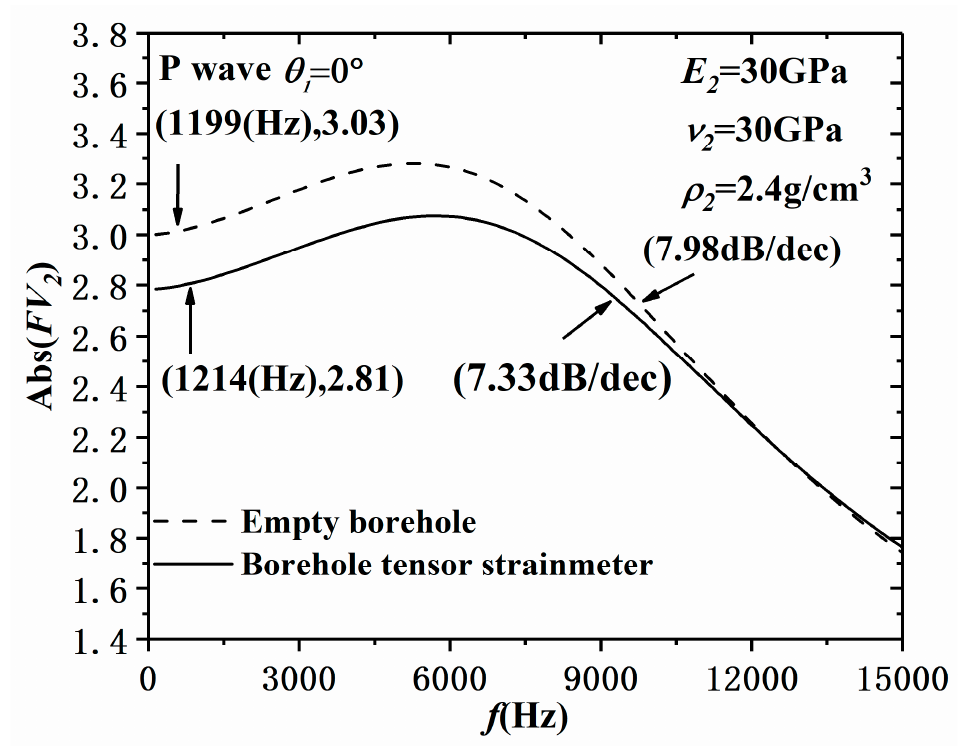
Figure 2. Theoretical amplitude spectrum of gauge combination FV 2 for the incident P wave. 141 Table 1. Characteristic values for the incident P wave amplitude spectrum of FV 2 , FV 4 , FS, TV and TS 142 at different θ 1. 143